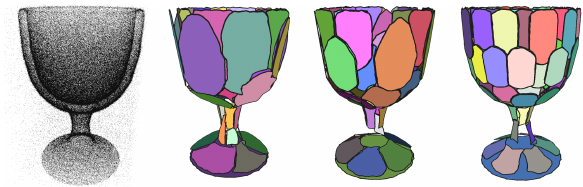
Figure 1: Multiscale Planar Abstraction. Left: Input point cloud of a goblet with outliers and noise. Mid to Right: Pla- nar abstraction with varying fitting tolerance from coarse to fine: 1% , 0 . 5% and 0 . 25% of bounding box diagonal.